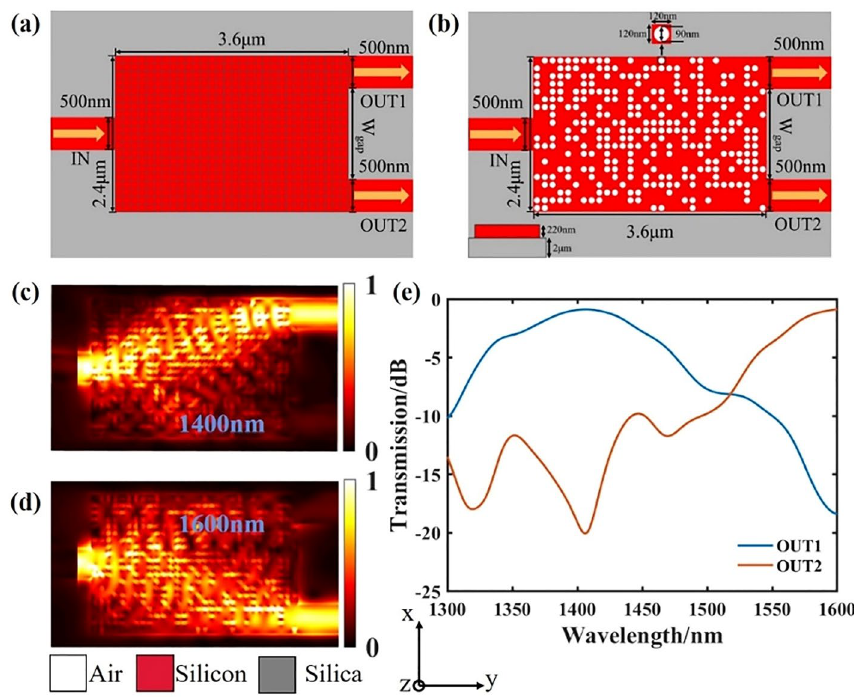
Figure 1. Design and simulation results of the wavelength demultiplexer. ( a ) Initial silicon slab before design optimization. ( b ) Final optimized structure. ( c , d ) are the simulated optical field distributions. ( e ) is the transmittance spectrum of each output